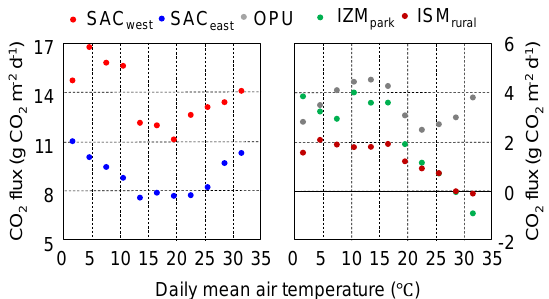
Figure 7. Relationship between the daily mean air temperature and the daily mean CO 2 flux; CO 2 flux data were binned at 3 ◦ C inter-